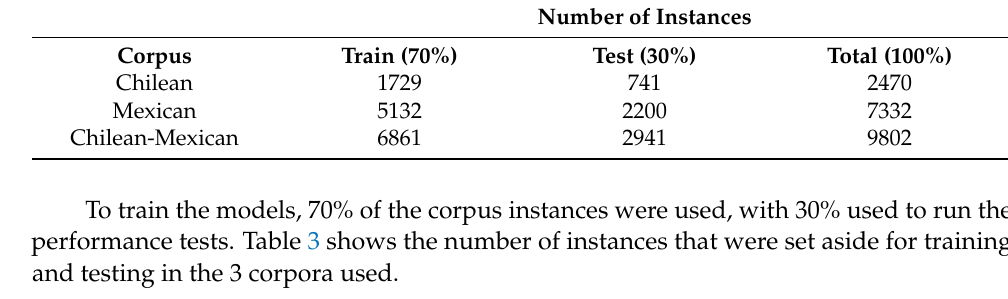
Table 3. Number of instances of training and testing of the